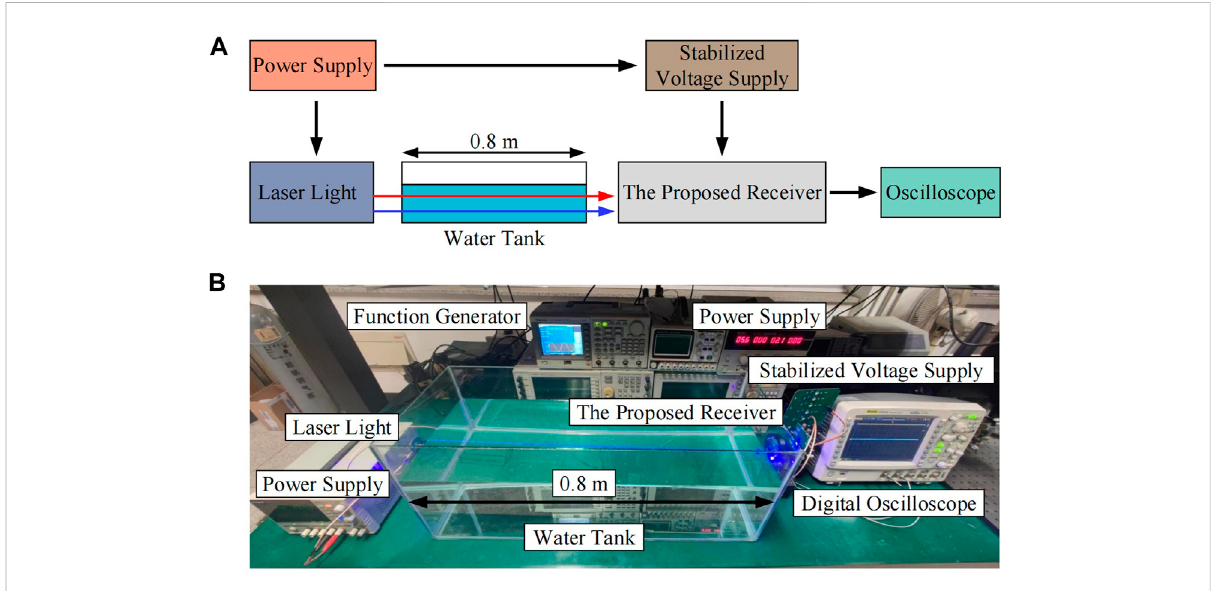
FIGURE 7 The testing setup of the proposed receiver cell. (A) The schematic of testing setup; (B) The experimental setup of the proposed cell. The underwater channel, the most challenging channels for data communications, is selected to evaluate the channel-fading-resistant ability of the optical receiver, and the water tank is used to simulate the harsh communication